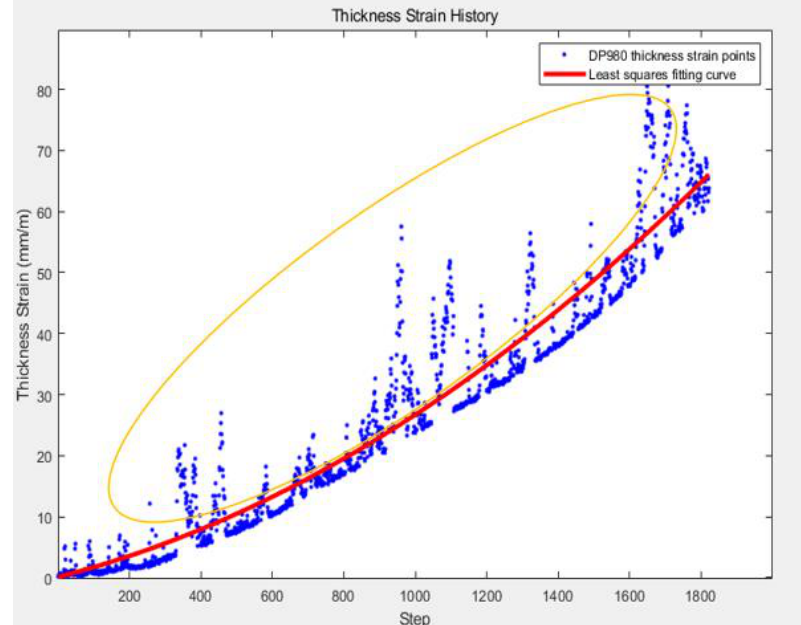
Figure 5. DP980 thickness strain fitted by least squares algorithm.